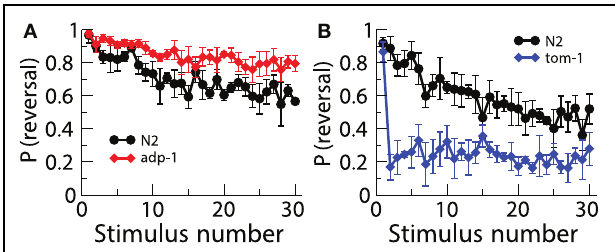
FIGURE 3 | Using the multi worm tracker to test a number of strains of worms uncovered new mutations affecting habituation. There was lower response probability habituation to tap in adp-1 worms (A) and greater response probability in tom-1 worms (B) (Swierczek et al.,